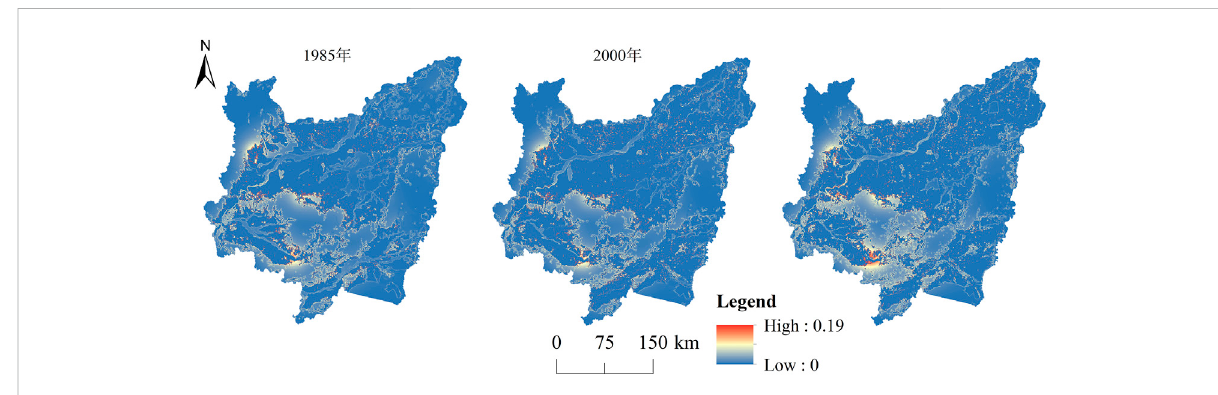
FIGURE 7 Spatial-temporal changes of degradation dgree.